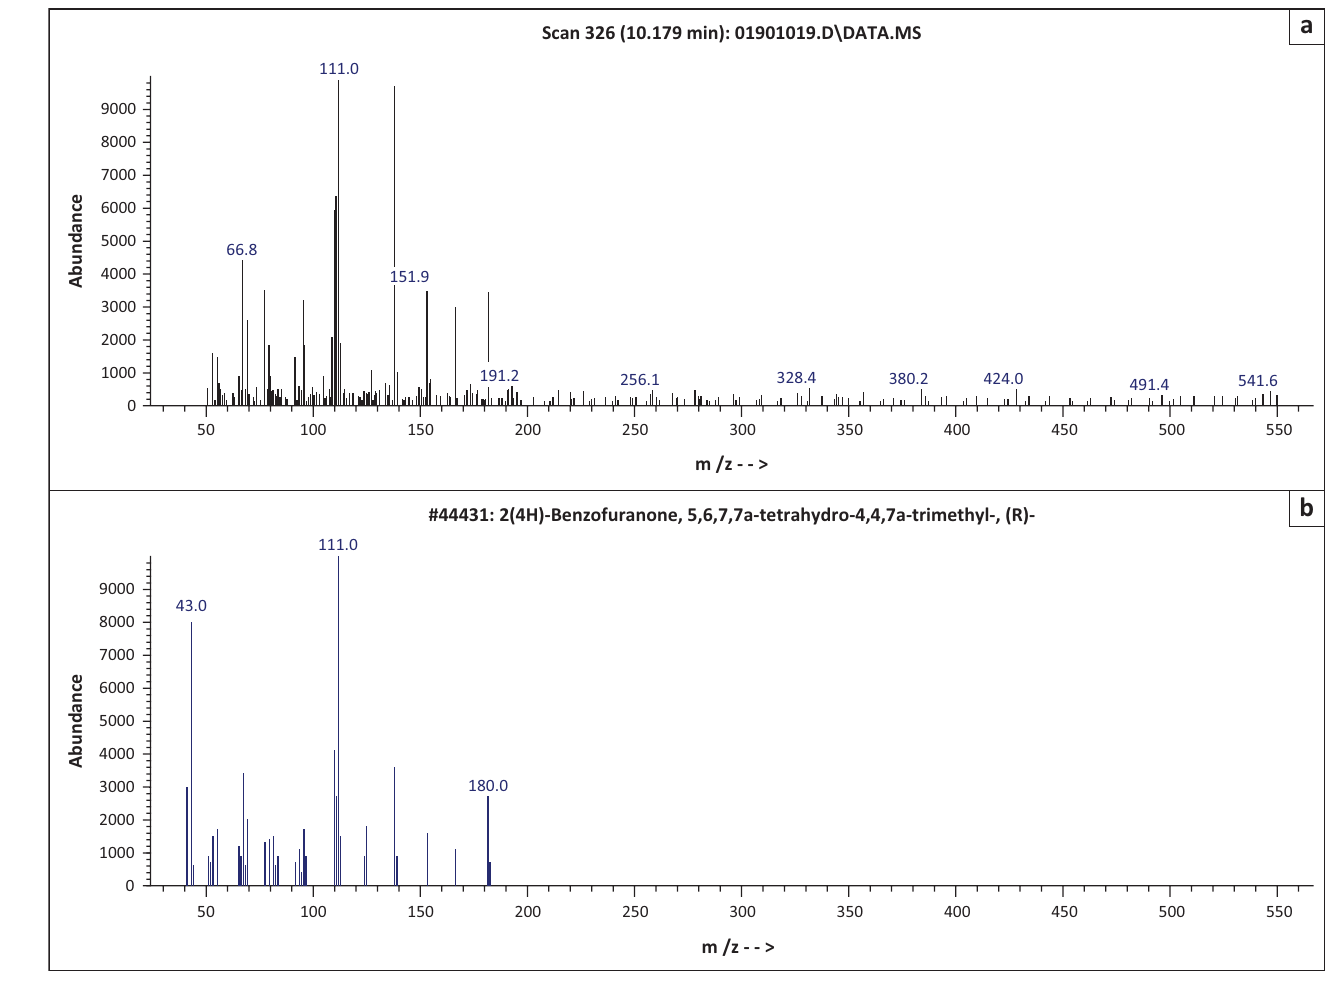
FIGURE 5: Gas chromatography – mass spectrometer spectra of 2(4H)-benzofuranone,